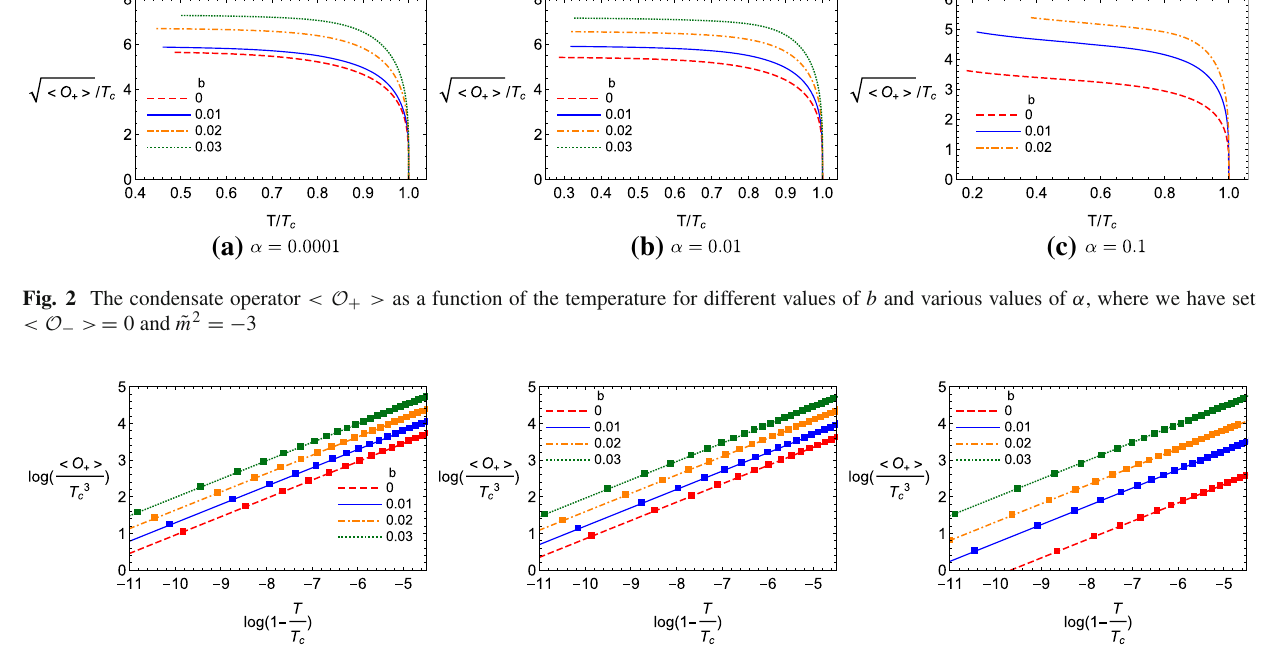
Fig. 3 These figures show the behavior of log α . The numerical results are highlighted in the filled